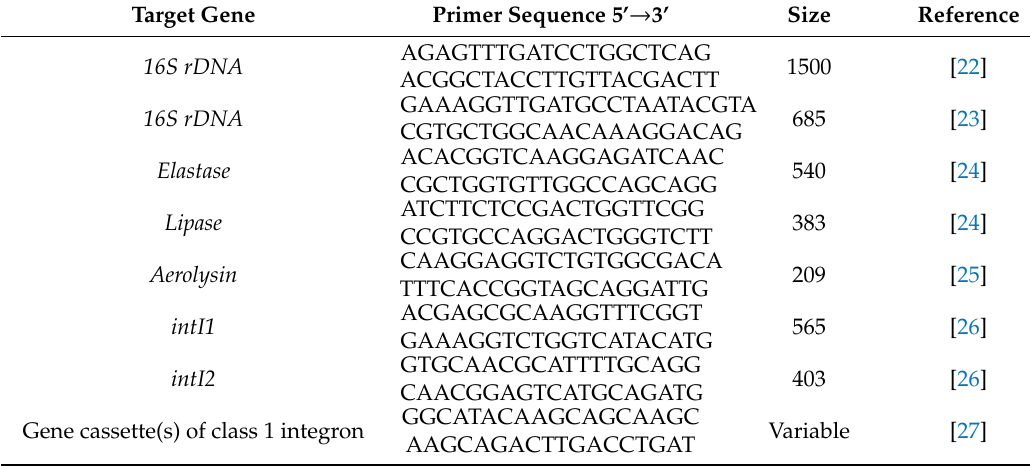
Table 1. Primers used for the identification of Aeromonas species, integrons, and the variable